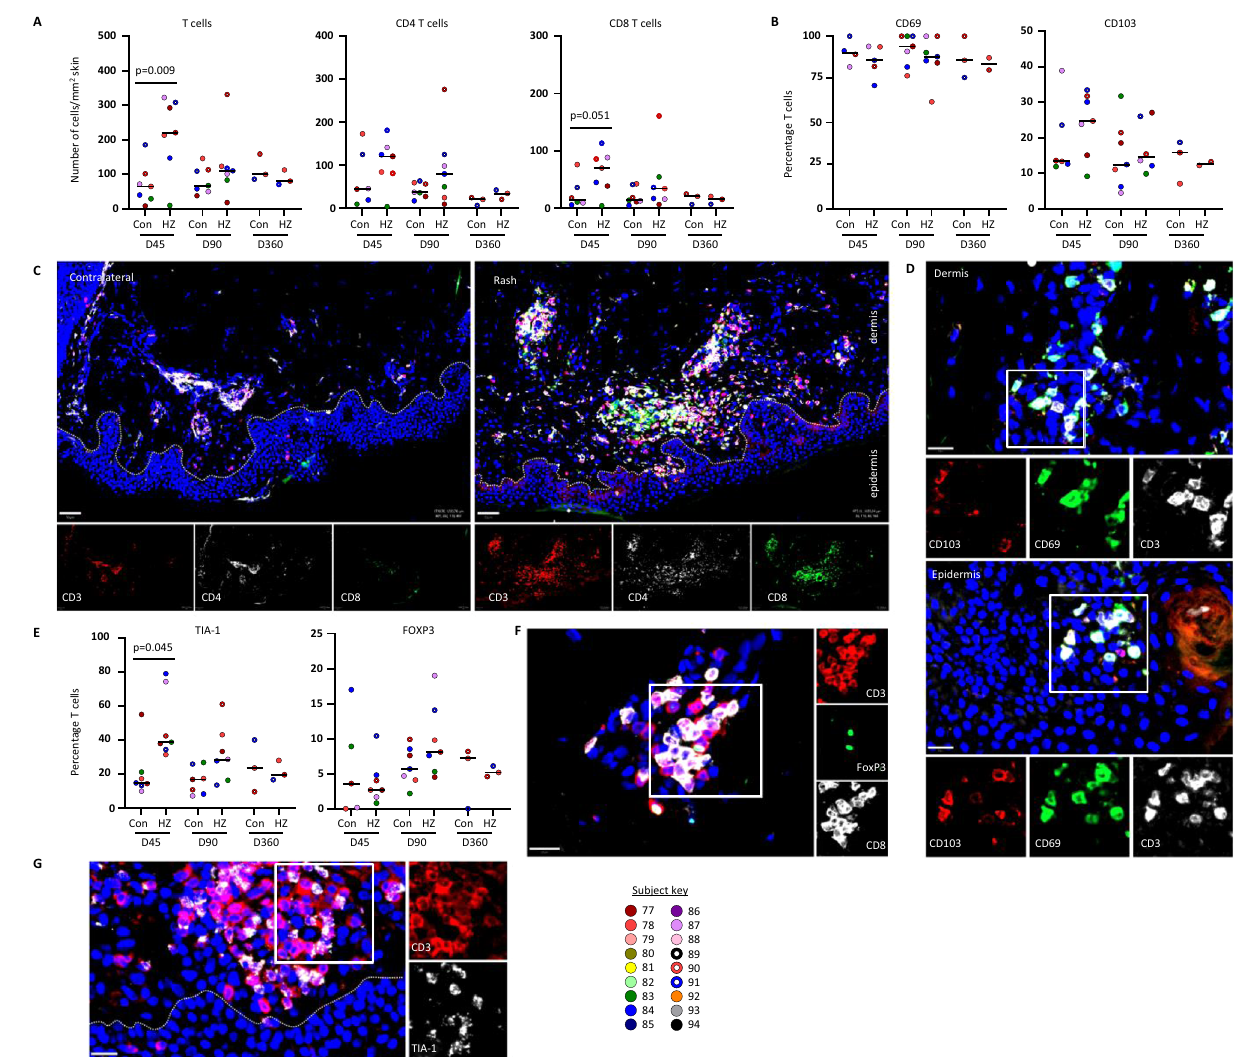
Fig. 2 | Detection T RM cells in herpes zoster-affected and contralateral human skin biopsies. Cryosections from rash site (HZ) and contralateral (Con) skin were analyzed for the expression of indicated markers by immuno fl uorescent staining. Total number and frequency of cells expressing the indicated markers were determined for each complete biopsy ( A, B and E ; data of individual subjects are shown in speci fi c colors) and representative images are shown ( C, D, F and G ). Wilcoxon paired tests were used to compare HZ to con samples at the same time point: unadjusted 2-tailed p values are shown where p ≤ 0.05. C Donor 91, day 45 (D45).Scalebar=50 µ m. D Donor78,D90,rashsite.Scalebar=20 µ m. F